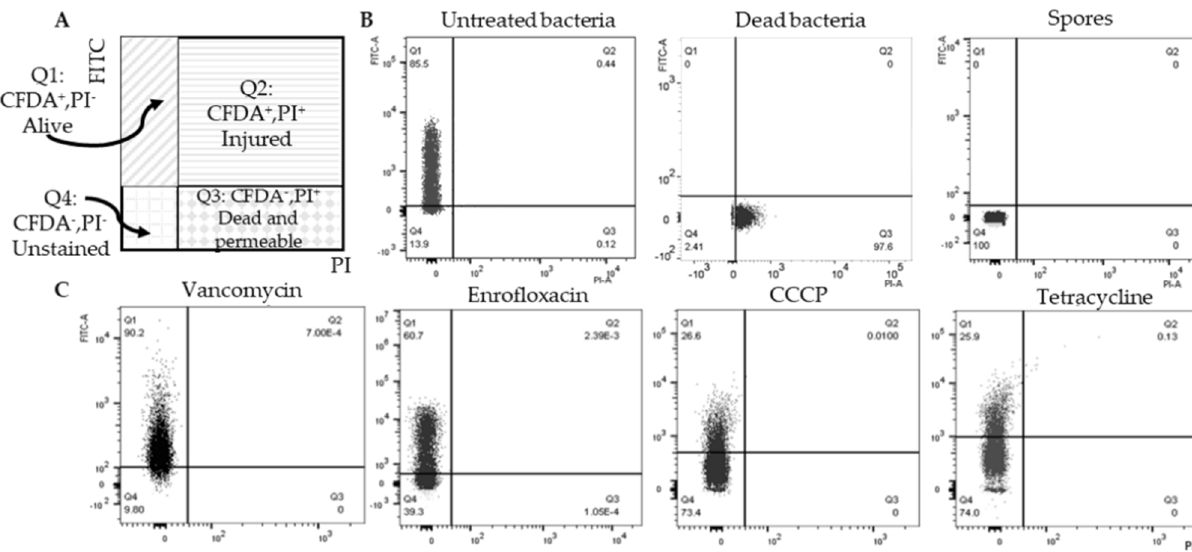
Figure 2. 5(6)-CFDA positive and PI negative cells are surviving non-spore cells. ( A ) The flow cytometry scheme of double stained samples; ( B ) Control groups: untreated bacteria (exponential growth phase bacteria), dead bacteria (isopropanol treated) and spores, were double stained with 5(6)-CFDA and PI and then analyzed with flow cytometry. While dead bacteria and spores were not stained by 5(6)-CFDA, Q1 indicated alive non-spore subpopulation in each sample. ( C ) shows flow cytometry patterns of bacteria after antimicrobial exposure and Q1 indicates surviving non-spore cells. 100,000 events in total were analyzed in each sample. This experiment was repeated three times.